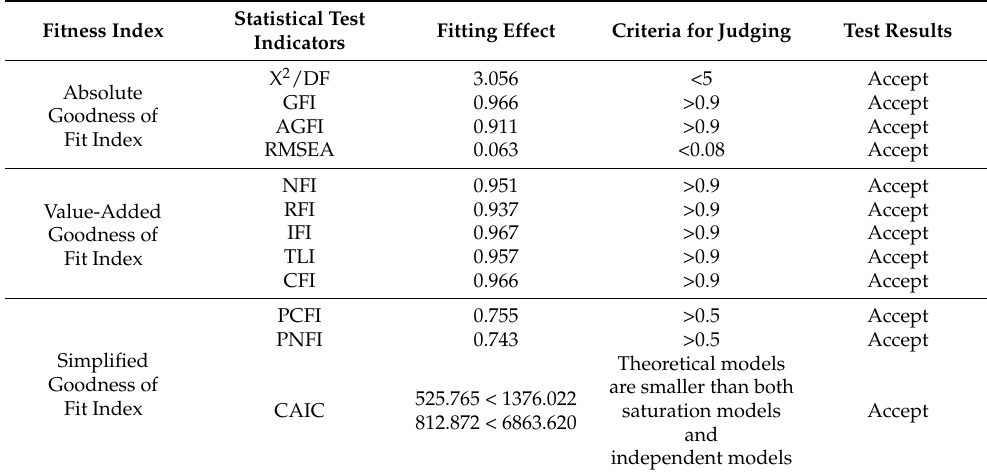
Table 4. Result of model goodness of